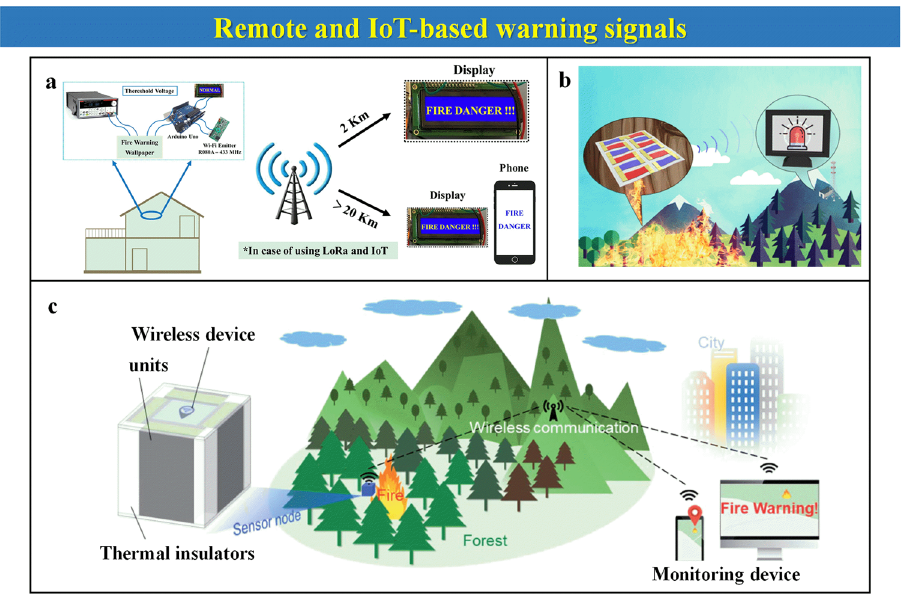
Fig. 15 Remote and wireless IoT‑based warning systems. a Schematic of wireless conversion from fire information to Wi‑Fi signal for remote monitoring fire alarm process. Reproduced with permission from Ref. [66]. Copyright 2021 Elsevier. b A remote EFWS from a forest. Repro‑ duced with permission from Ref. [96]. Copyright 2020 American Chemical Society. c forest fire‑warning system based on wireless conversion. Reproduced with permission from Ref. [115]. Copyright 2021 The Royal Society of